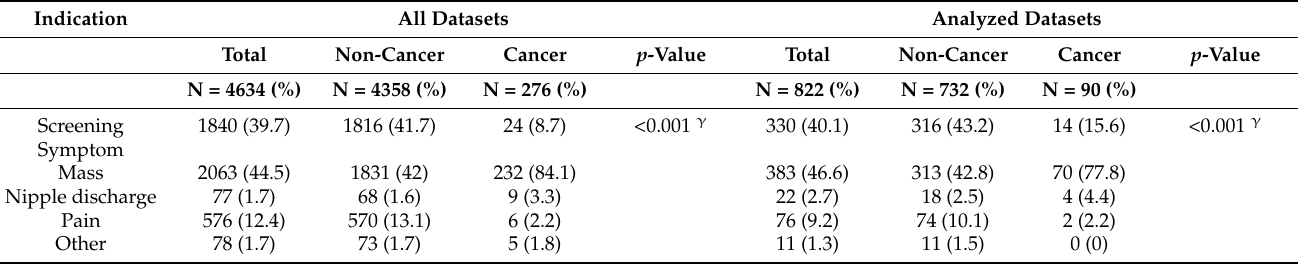
Table 1. Indication and final diagnosis for women at their first mammogram visit.